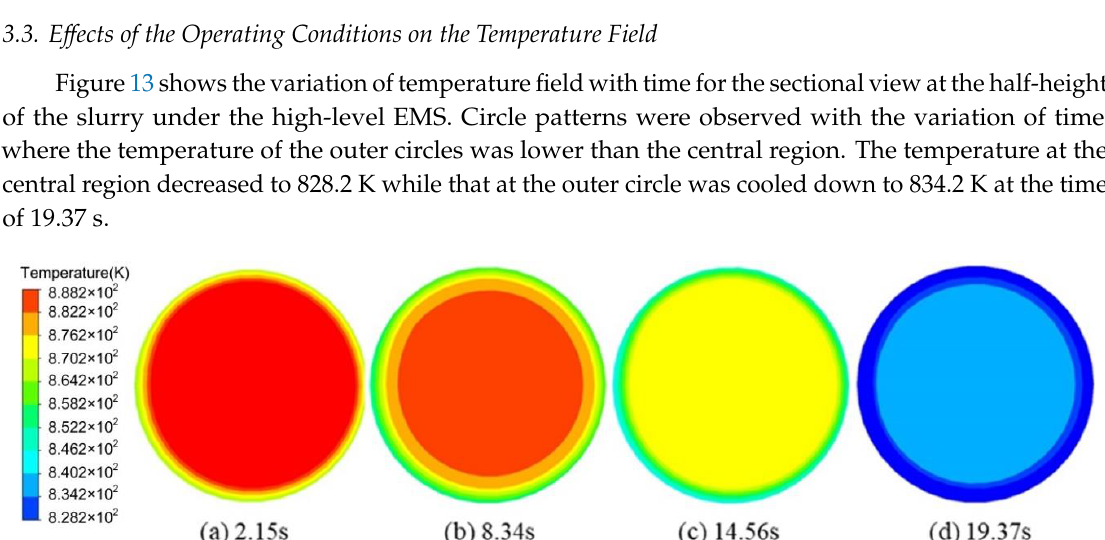
Figure 13. Variation of the temperature field with time under the high-level electromagnetic stirring (EMS).